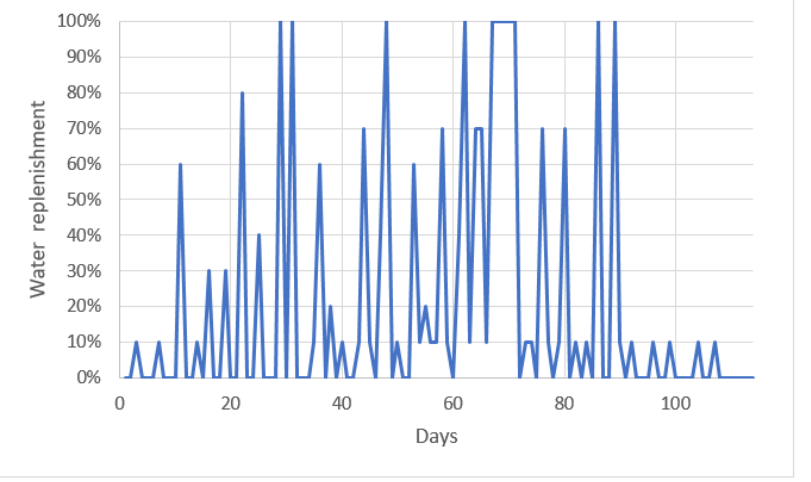
Figure 8. The filtration cleaning and water replenishment in the SANFU II RAS in one cycle. Notes: Filtration cleaning always took place when the water replenishment was above 5 percent. Source: